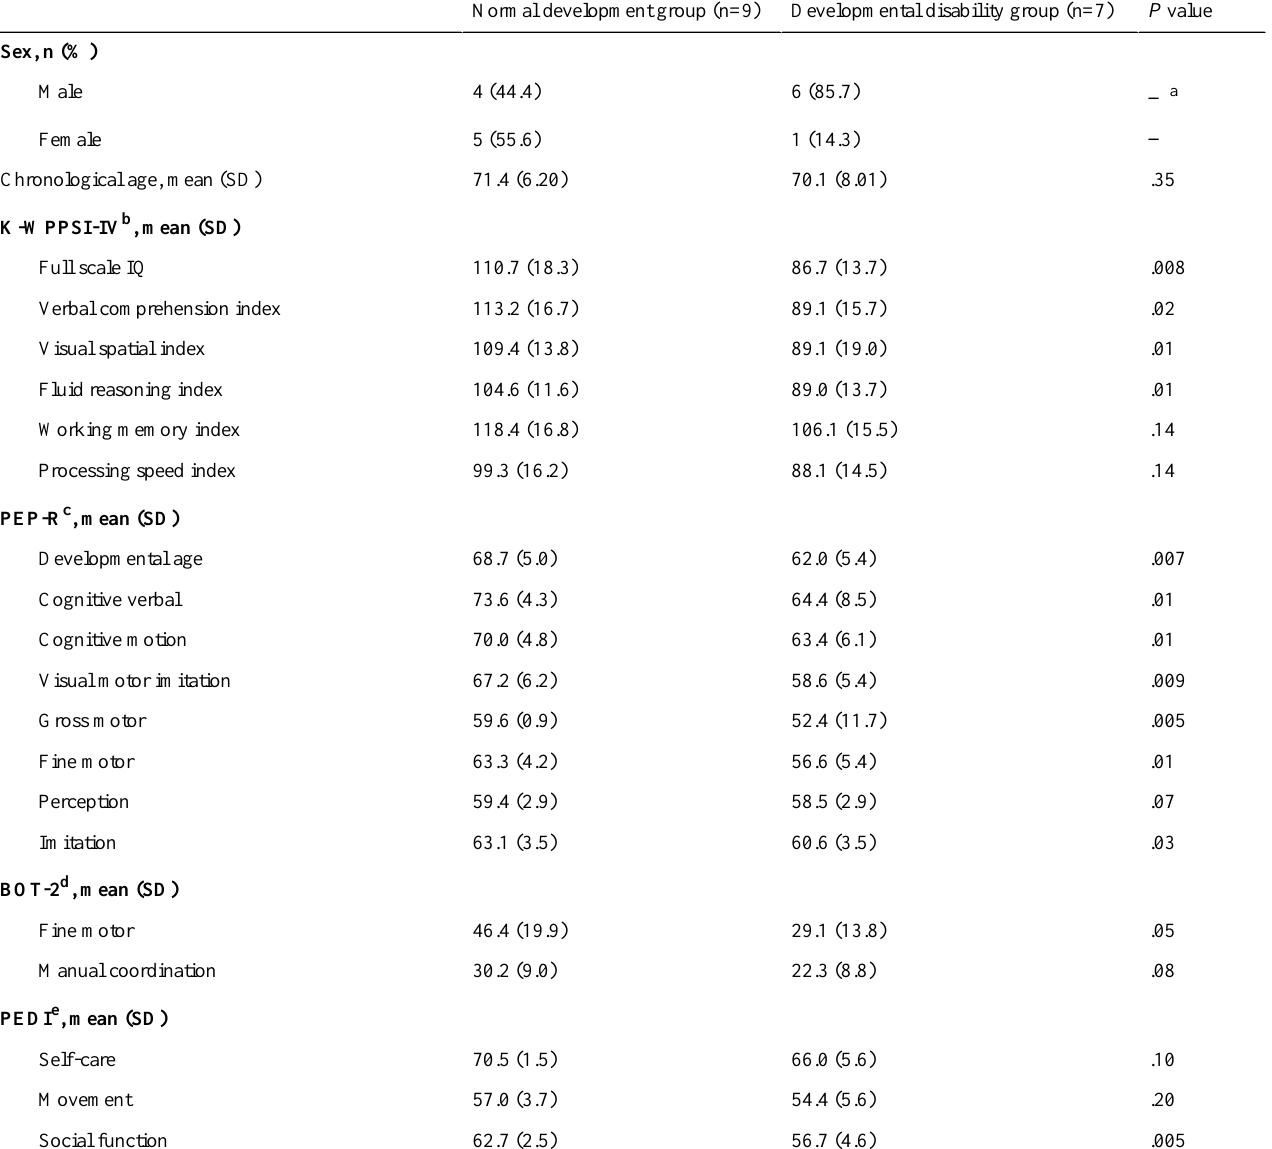
P valueDevelopmental disability group (n=7)Normal development group (n=9)